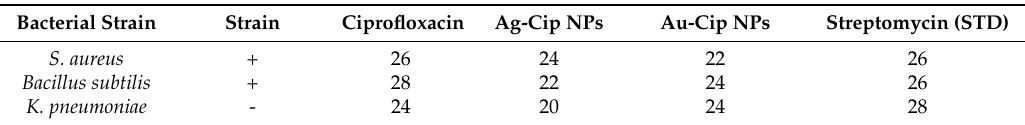
Table 2. Antibacterial activities of ciprofloxacin and its metallic (Ag/Au) nanoparticles (zone of inhibition (mm) at 3